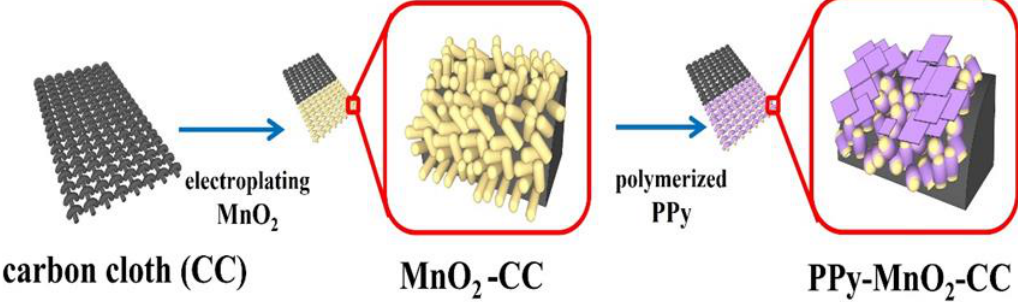
Figure 1. Schematic illustration of the construction process of MnO 2 -CC and PPy-MnO 2 -CC electrodes.